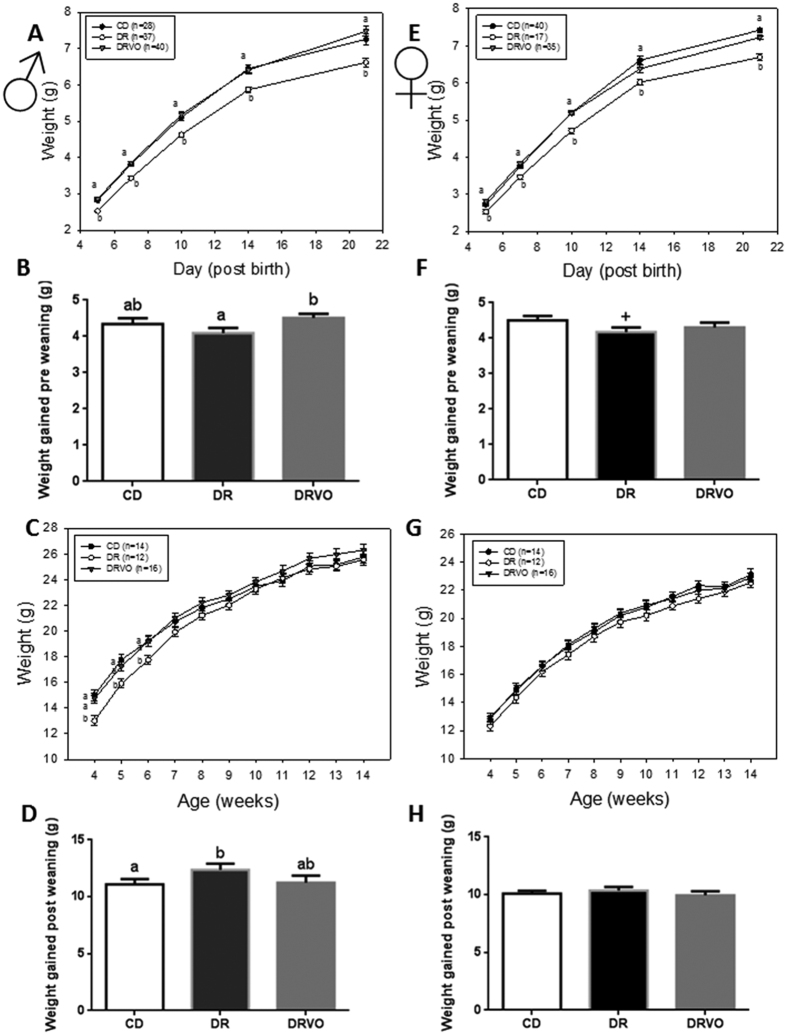
Vitamin and antioxidant supplementation of under nourished fathers restores neonatal size and growth.(A) Early postnatal growth of male offspring until weaning (21 days old). (B) Total weight gained in male offspring from day 5 until day 21. (C) Weights of male offspring from 4 weeks until 14 weeks. (D) Male offspring total amount of weight gained post weaning from 4 weeks of age until 14 weeks. (E) Early postnatal growth of female offspring until weaning (21 days old). (F) Total weight gained in female offspring from day 5 until day 21. (G) Weights of female offspring from 4 weeks until 14 weeks. (H) Female offspring total weight gained post weaning from 4 weeks until 14 weeks. Data represents 28 male and 40 female offspring from 7 litters representing 6 founder males for CD, 37 male and 17 females from 6 litters representing 6 founder males for DR and 40 male and 35 female offspring from 8 litters representing 8 founder males for DRVO. Statistical significance was determined by repeated measures ANOVA, with founder ID added as a random factor to both pre and post weaning weights and mother ID added as a random factor to pre weaning weights, to adjust outcomes for offspring generated from the same founder and same mother. Data is expressed as mean ± SEM. Different letters denote significance at P < 0.05; +denotes significance to CD and DRVO at p = 0.06.